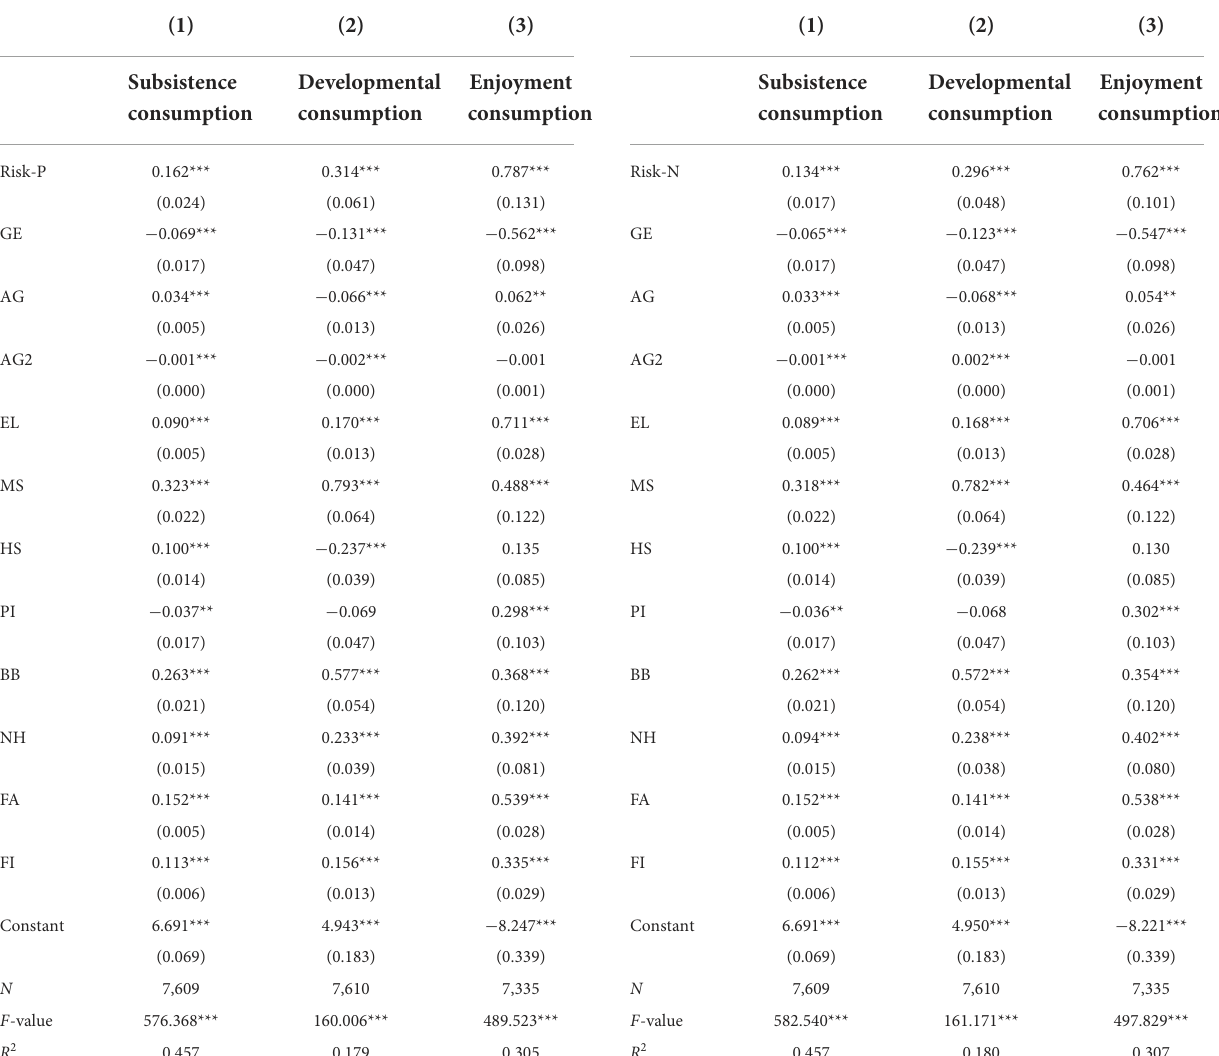
TABLE 11 The impact of risk preference on household total consumption behavior.